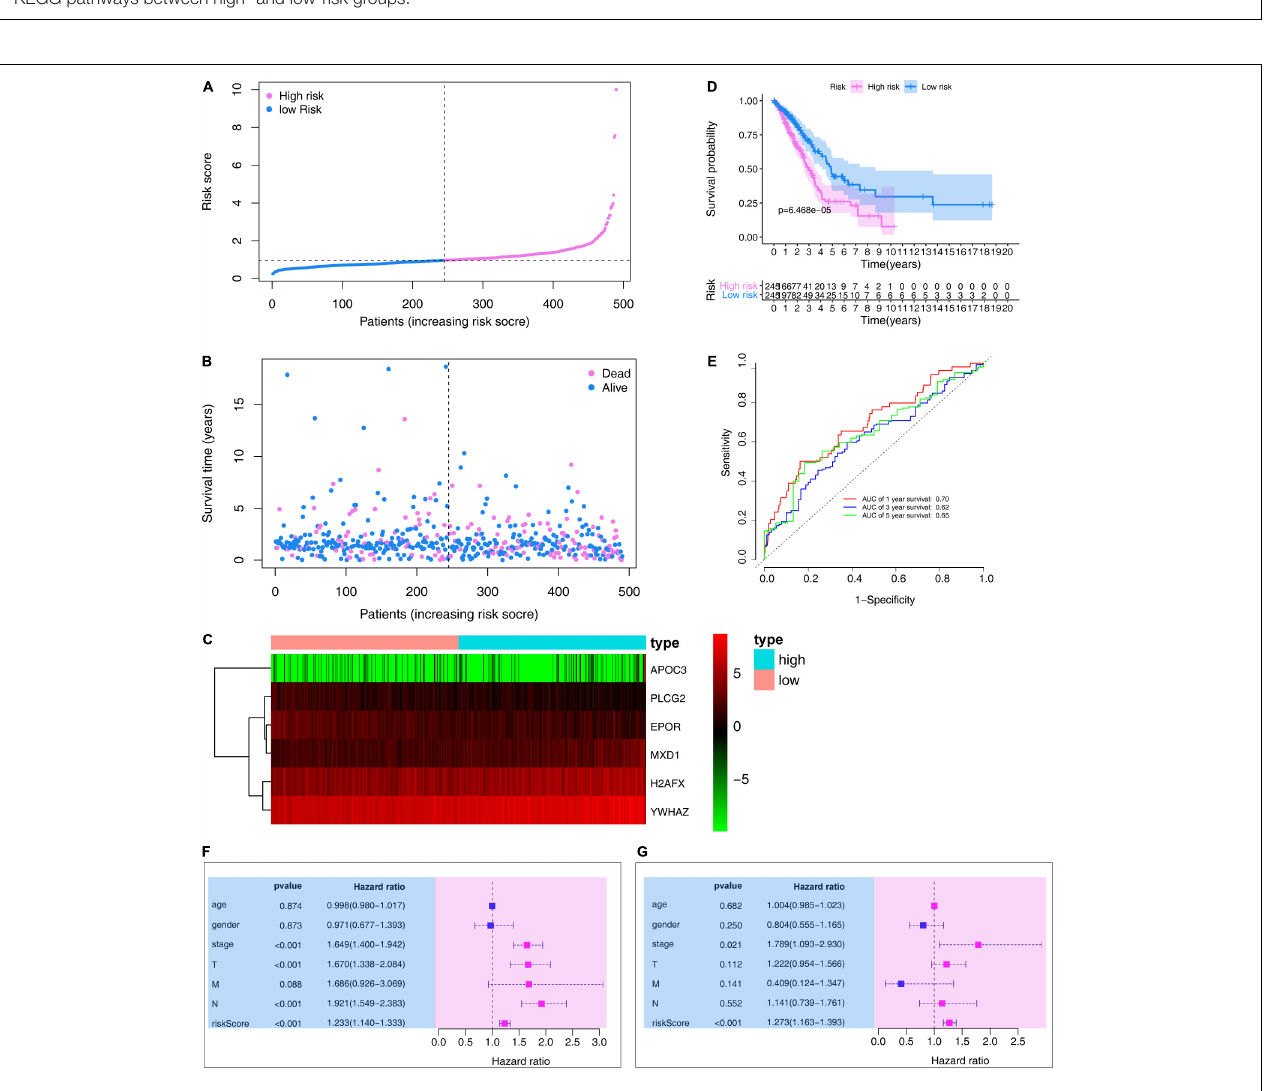
FIGURE 4 | Evaluation the prognostic value of the ARG signature in the training set. (A) Distribution of the risk scores calculated by the risk score. (B) Patient distribution in the low- and high-risk score groups based on survival status. (C) Heatmap of the ARG expression profiles. (D) Overall survival curves stratified by the low- and high-risk group. (E) Time-dependent ROC curves for ARG-based overall survival prediction. (F) Univariate Cox regression analysis of signature and other clinical factors. (G) Multivariate Cox regression analysis of signature and other clinical factors.